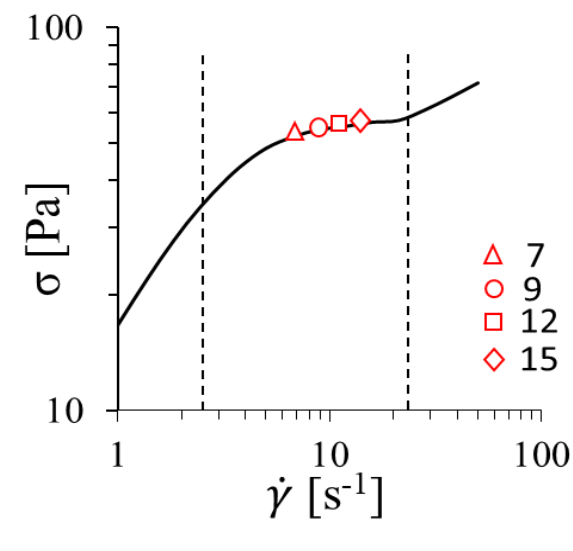
Figure 1: Stress vs applied shear rate for 6% CPCl/NaSal wormlike micelle solution, exhibiting a stress plateau characteristic of shear banding that extends from ˙ 𝛾 2.6 s −1 to ˙ 𝛾 24 s −1 (region l ≈ h ≈ between the two dashed lines). The red symbols correspond to the four different applied shear rates [s −1 ] used in shear startup experiments, demonstrating where these shear rates fall in the stress